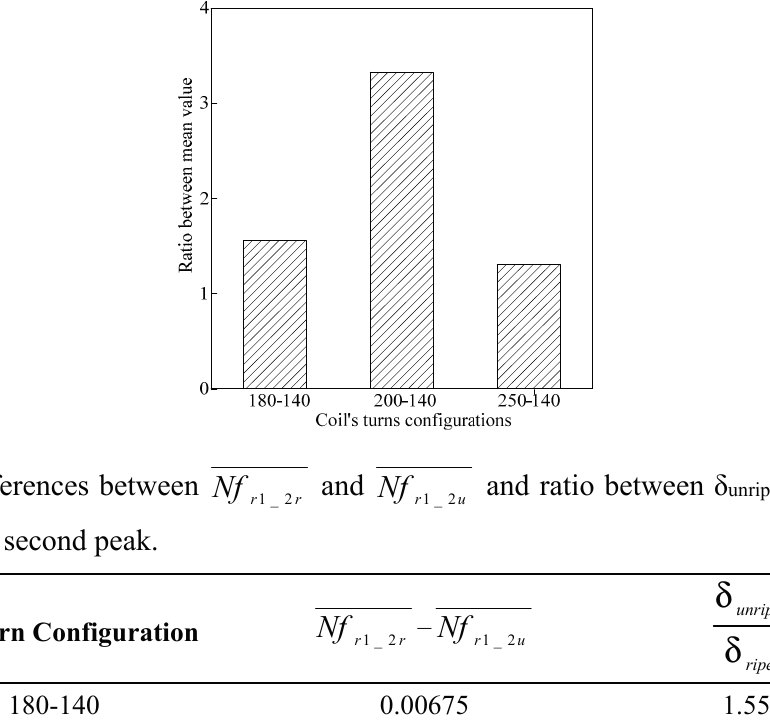
Figure 14. Ratio between δ unripe and δ ripe for dual peaks.